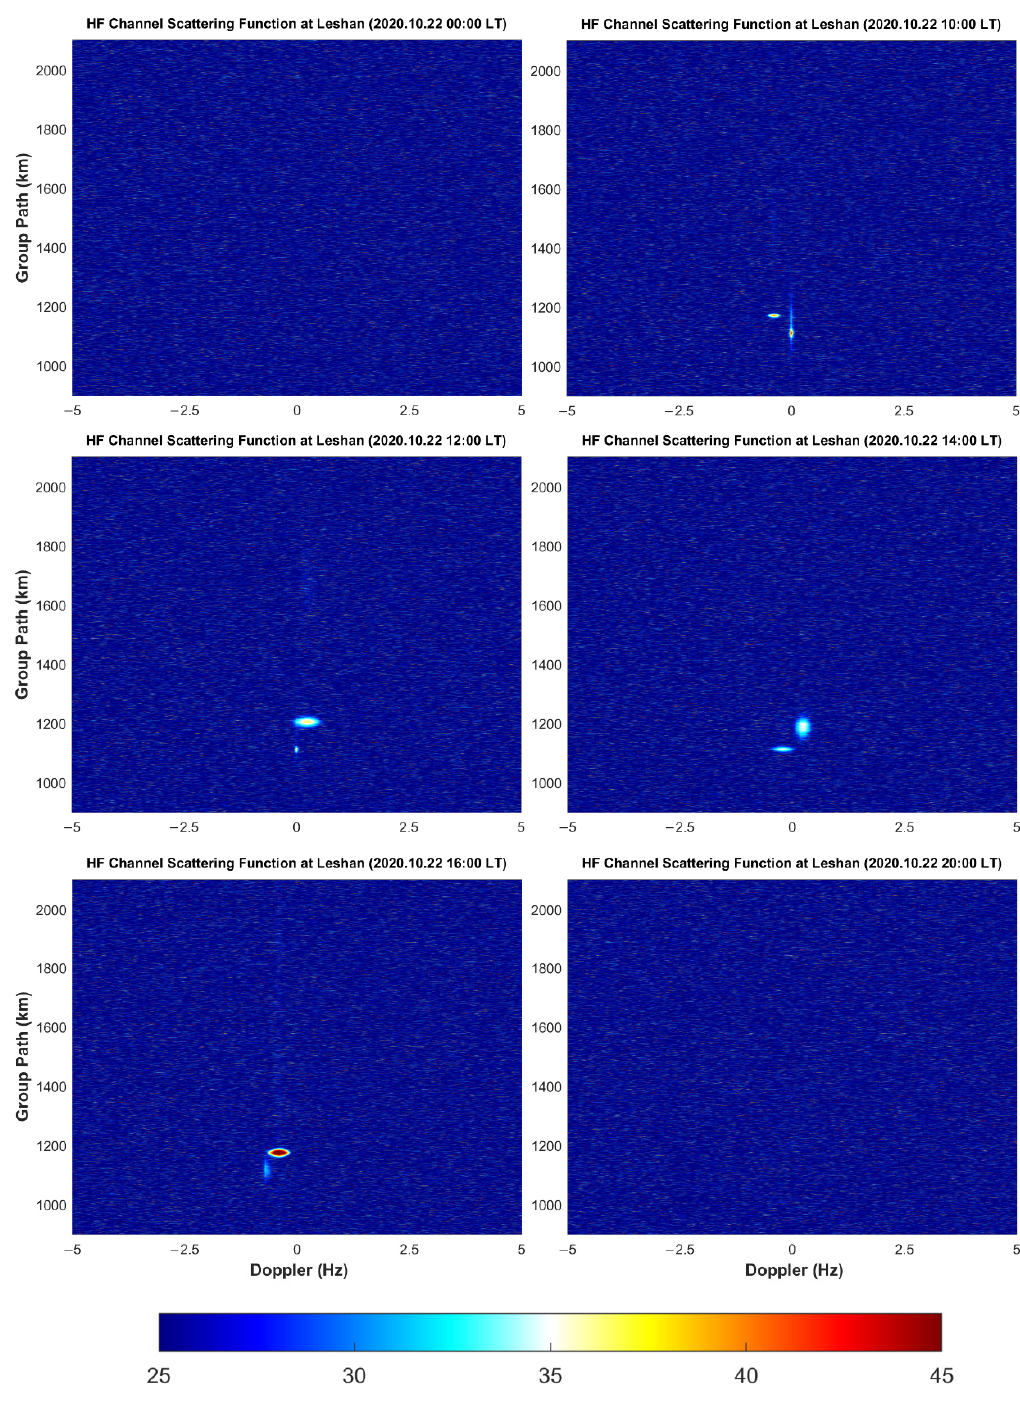
Figure 11. 22 October 2020, modeling and simulation results of the HF channel at Leshan station. Refer to the captions in Figure 10 for the receiving time and other descriptions of each